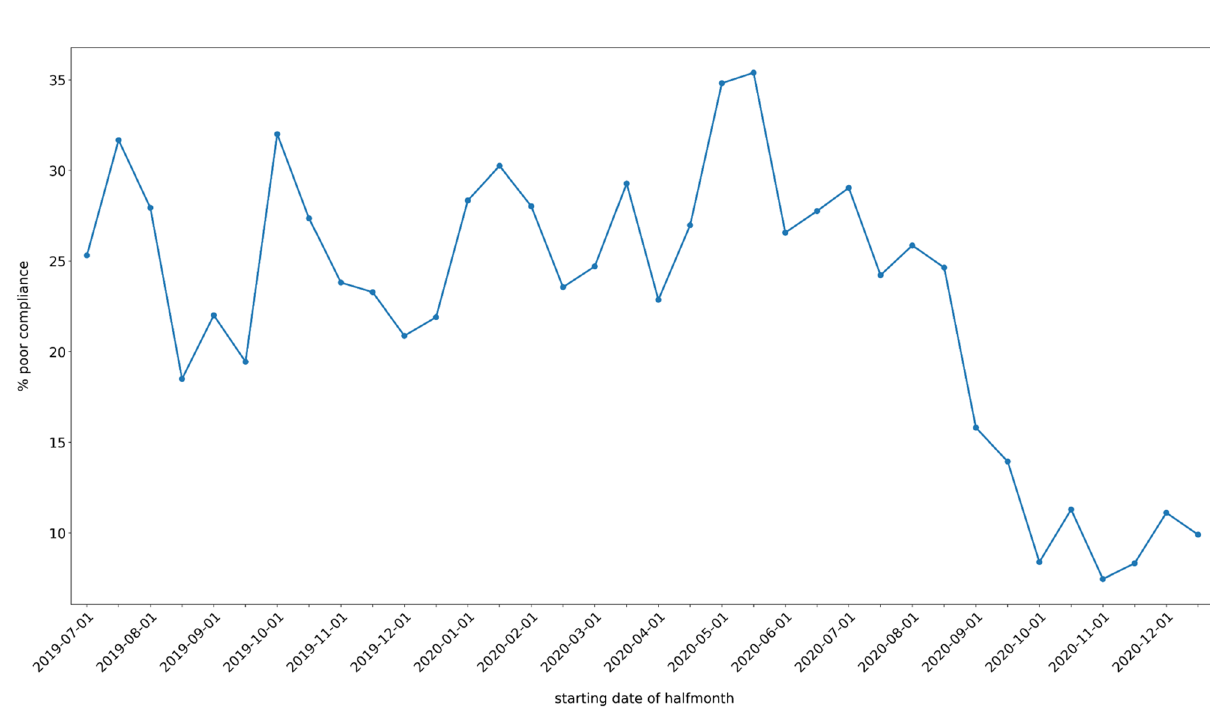
Figure 2. Mean poor compliance by starting date of treatment. Note that this figure contains data from the mid-period (January to June 2020), which was excluded from the statistical